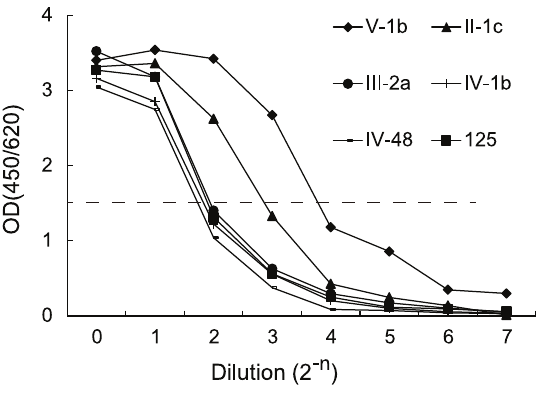
Figure 1. Titration of phage displaying p125 and related 12mer peptides. 10 13 phage displaying the p125 or the related 12mer peptides, V-1b, II-1c, III-2a, IV-1b, and IV-48 was serially diluted and allowed to react with microplates previously coated with 8H5 for 30 min. The plates were in turn reacted with anti-phage. The 8H5 binding activity of the phage is determined from the titration curves and expressed as the phage dilution yielding an OD value of 1.5 (T OD1.5 ).